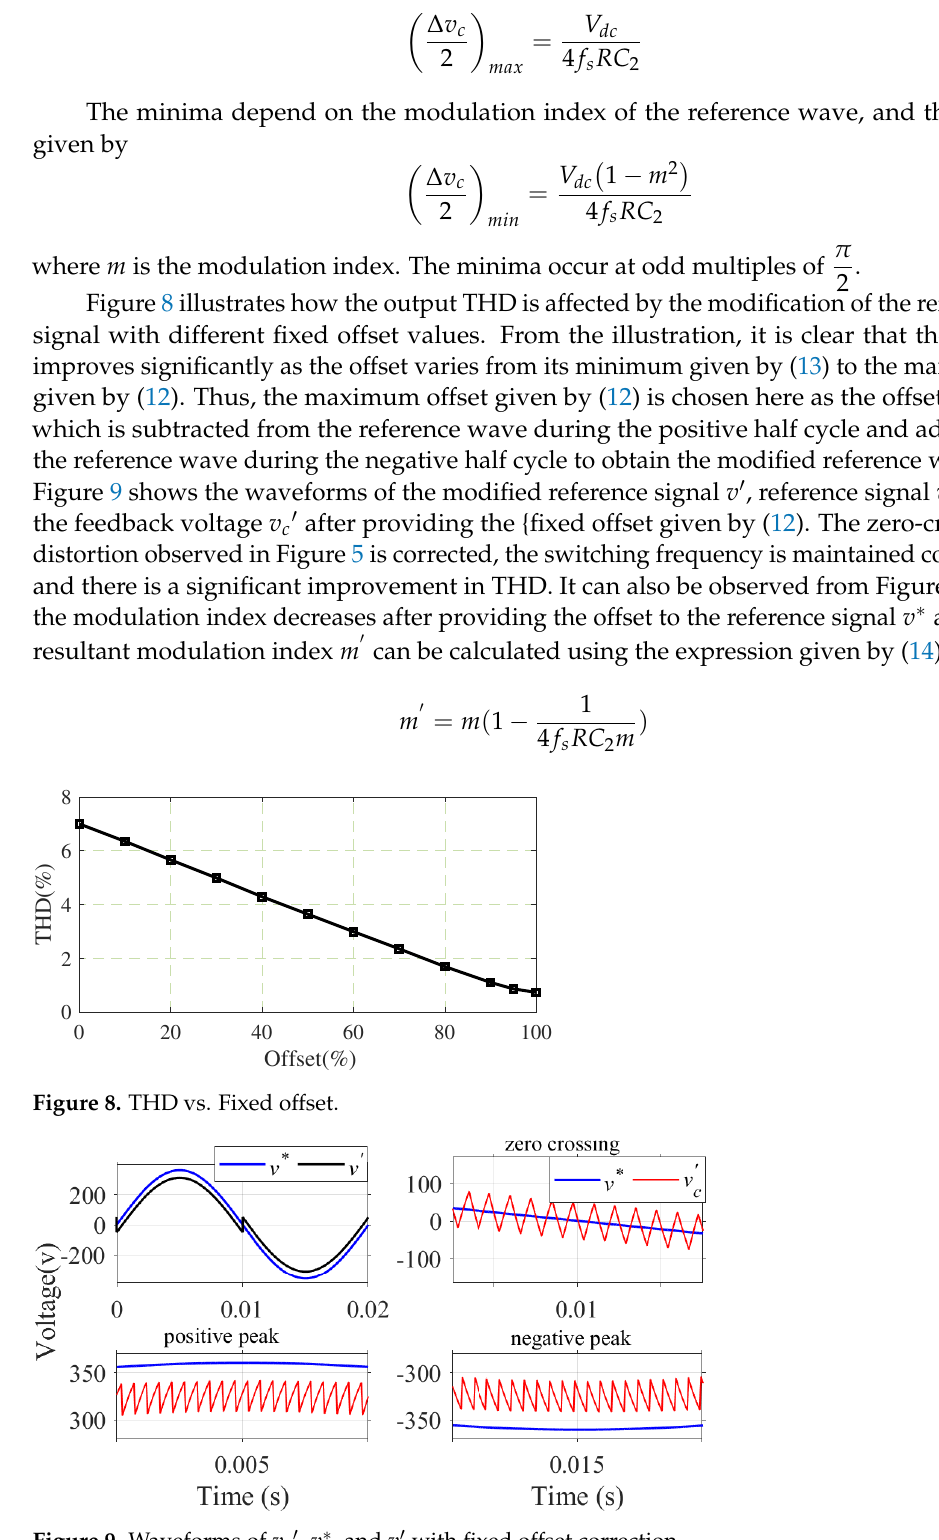
Figure 9. Waveforms of v c (cid:48) , v ∗ , and v (cid:48) with fixed offset